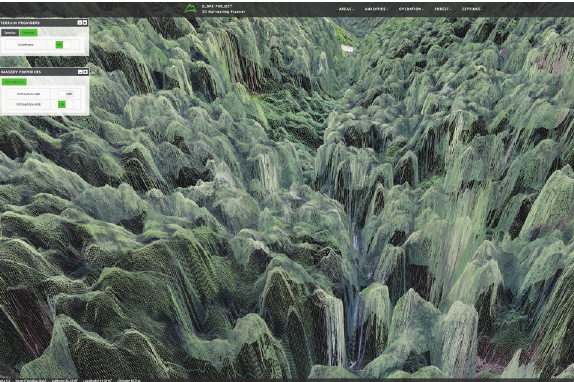
Figure 7. Real-time canopy digital surface model (DSM)